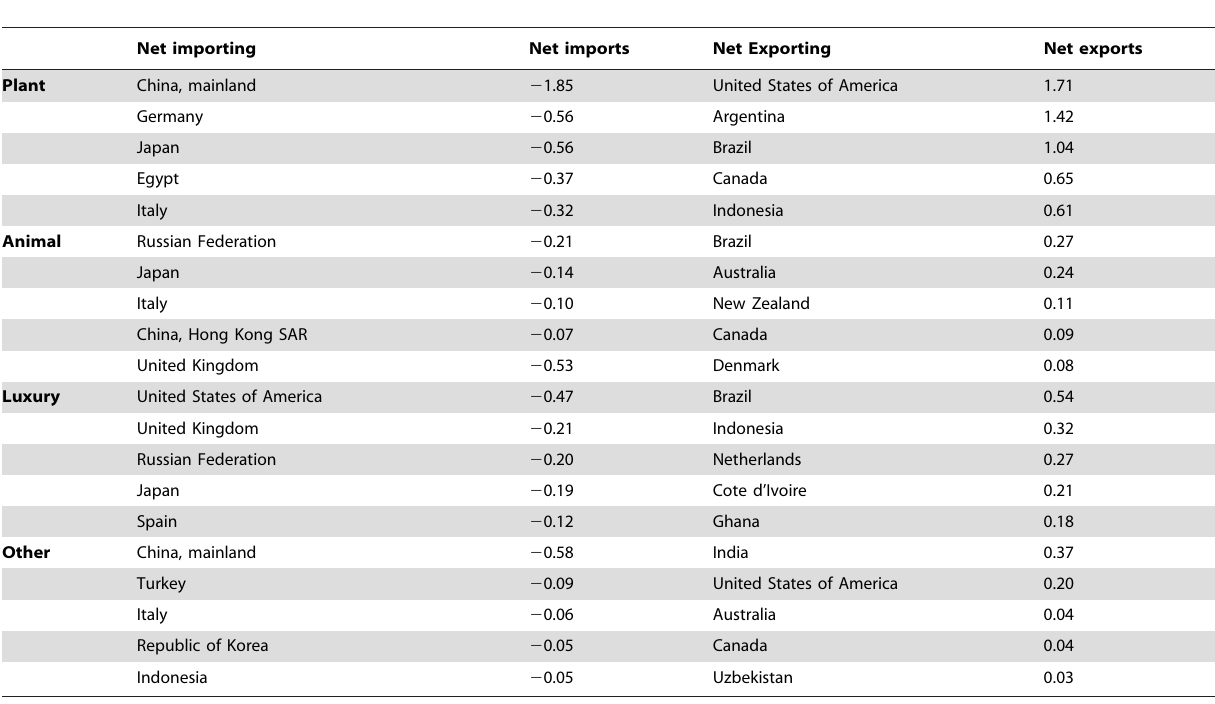
Table 3. The top 5 net importers (left) and net exporters (right) and their virtual water export import balance (10 11 m 3 ) for the year 2010 in the four commodity type networks.